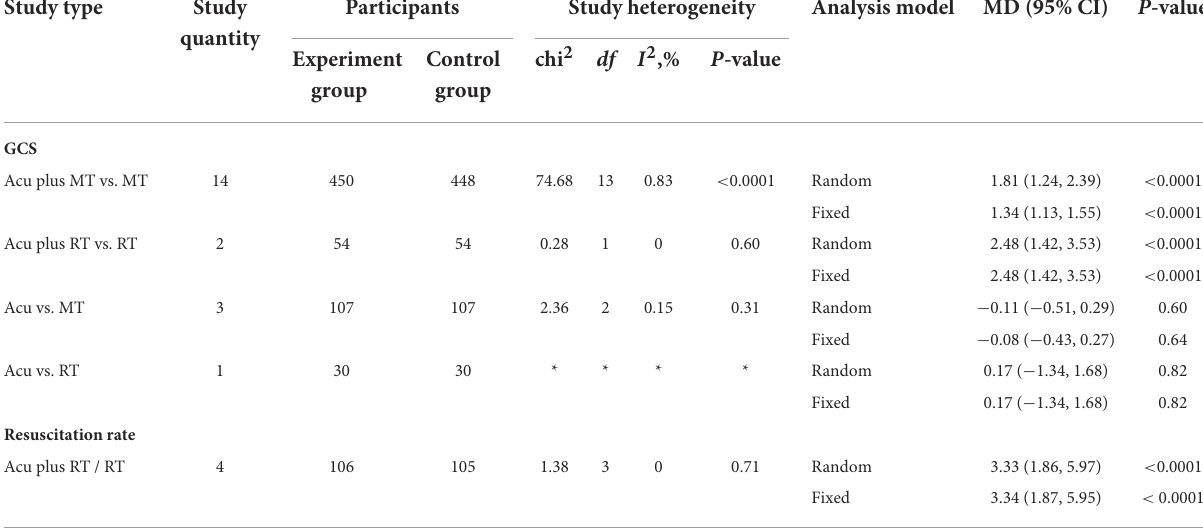
TABLE 2 Results of the sensitivity